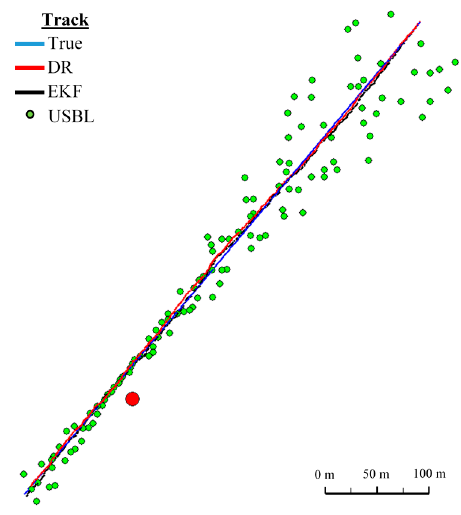
Figure 16. Determined route (single passage).